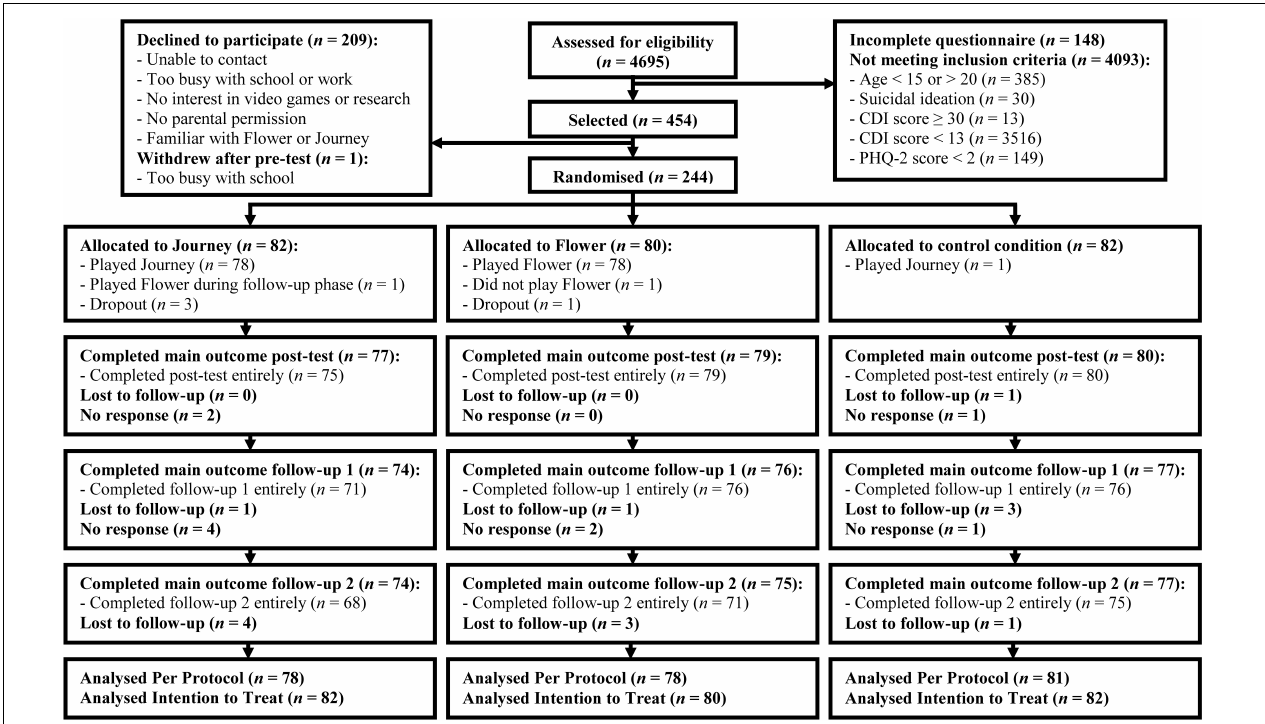
FIGURE 2 | Flow chart participants from screening to 12 month